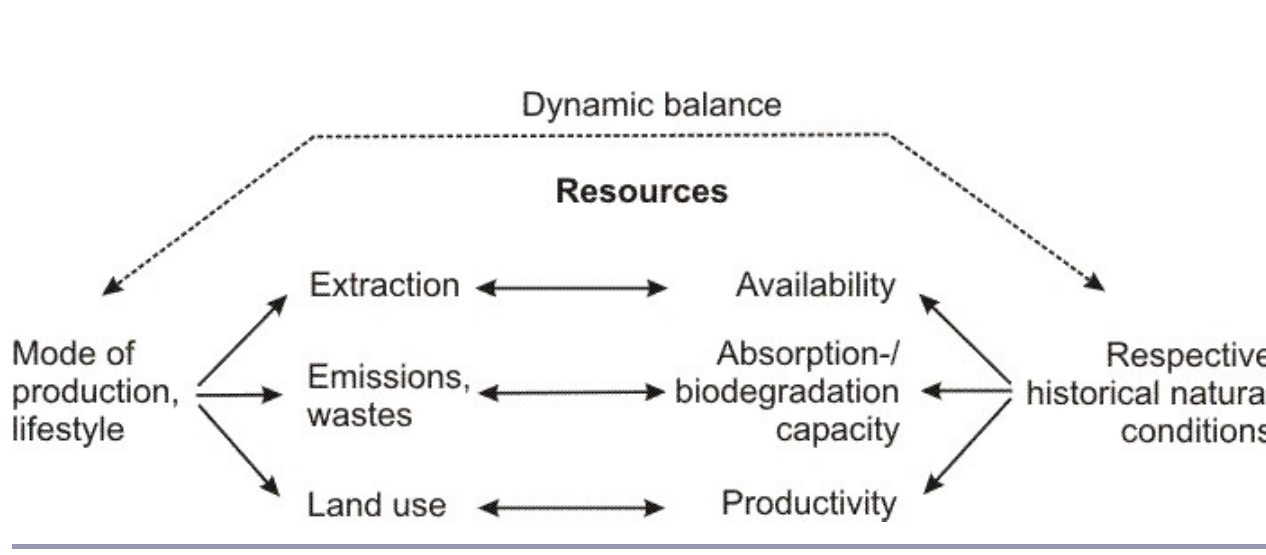
Fig. 1. Sustainability as the dynamic balance between mode of subsistence/lifestyle and the respective historical natural